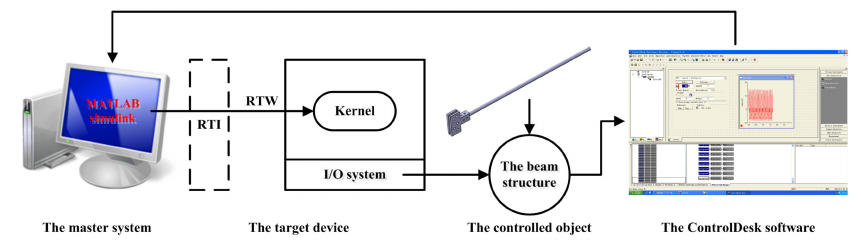
Figure 12. The diagram of the semi-physical simulation platform dsPACE.